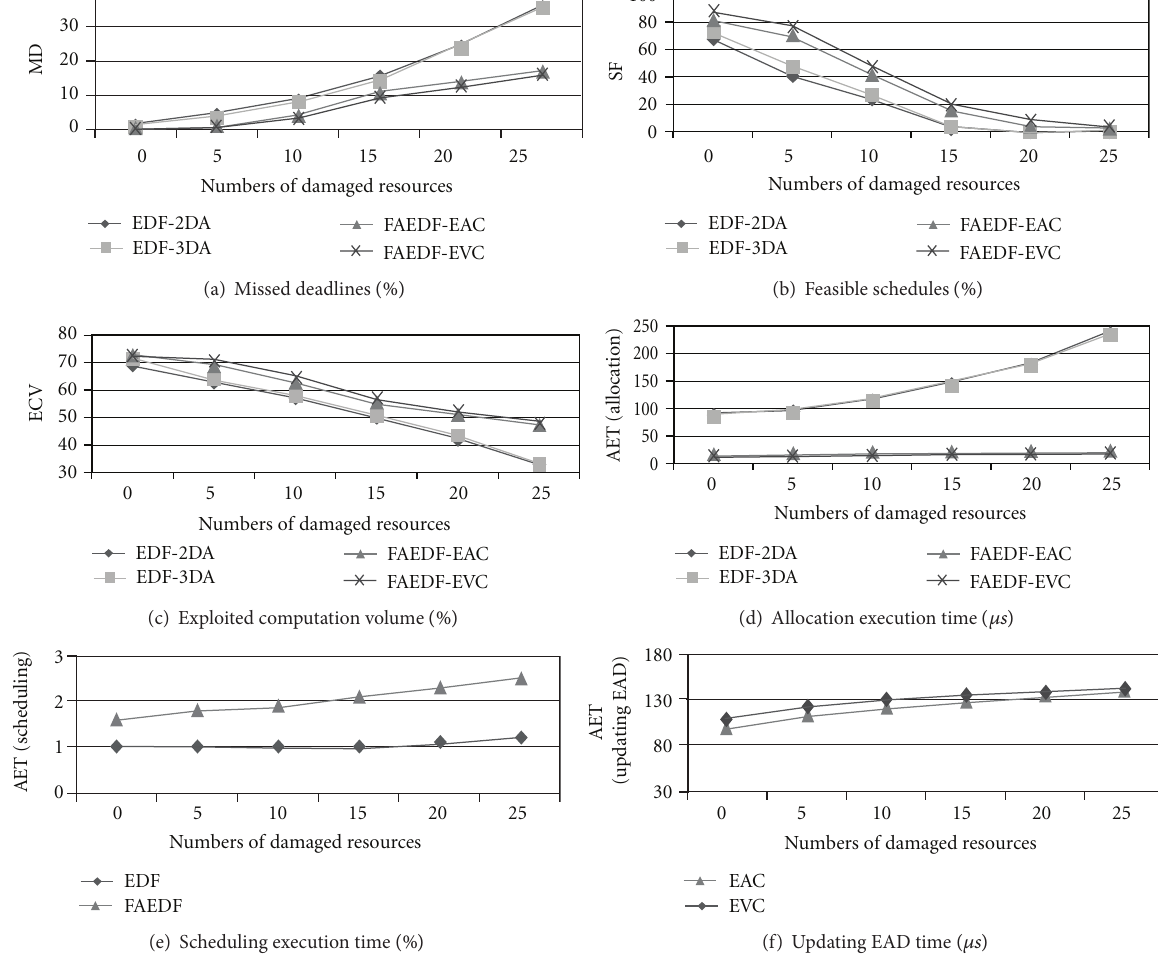
Figure 17: High utilization of the FPGA and loose real-time requirements: 𝑈